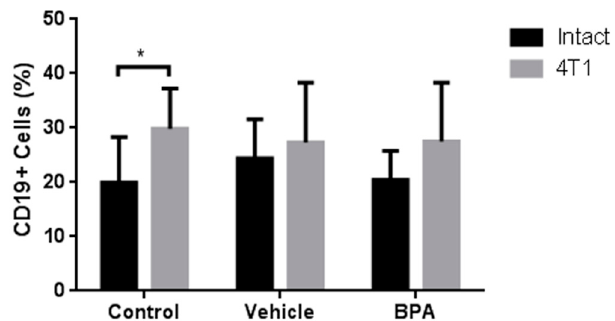
Figure 7. Percentage of B cells in the PLN of the offspring of BPA treated mice. PLN B Lymphocytes. Control ( n = 7), vehicle ( n = 6), vehicle/4T1 ( n = 7), BPA ( n = 7), and BPA / 4T1 ( n = 5). Data are expressed as the mean and standard deviation of the population percentage. * p < 0.05.